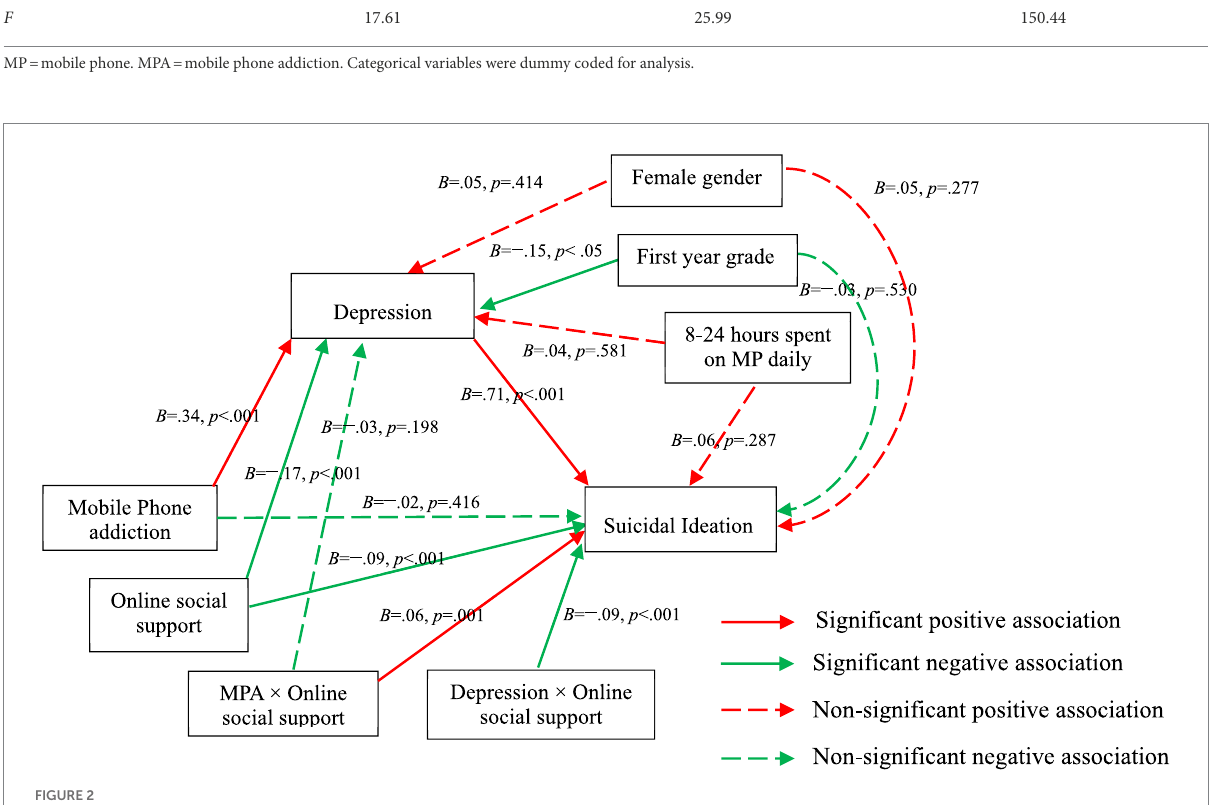
FIGURE 2 Statistical diagram for the moderated mediation